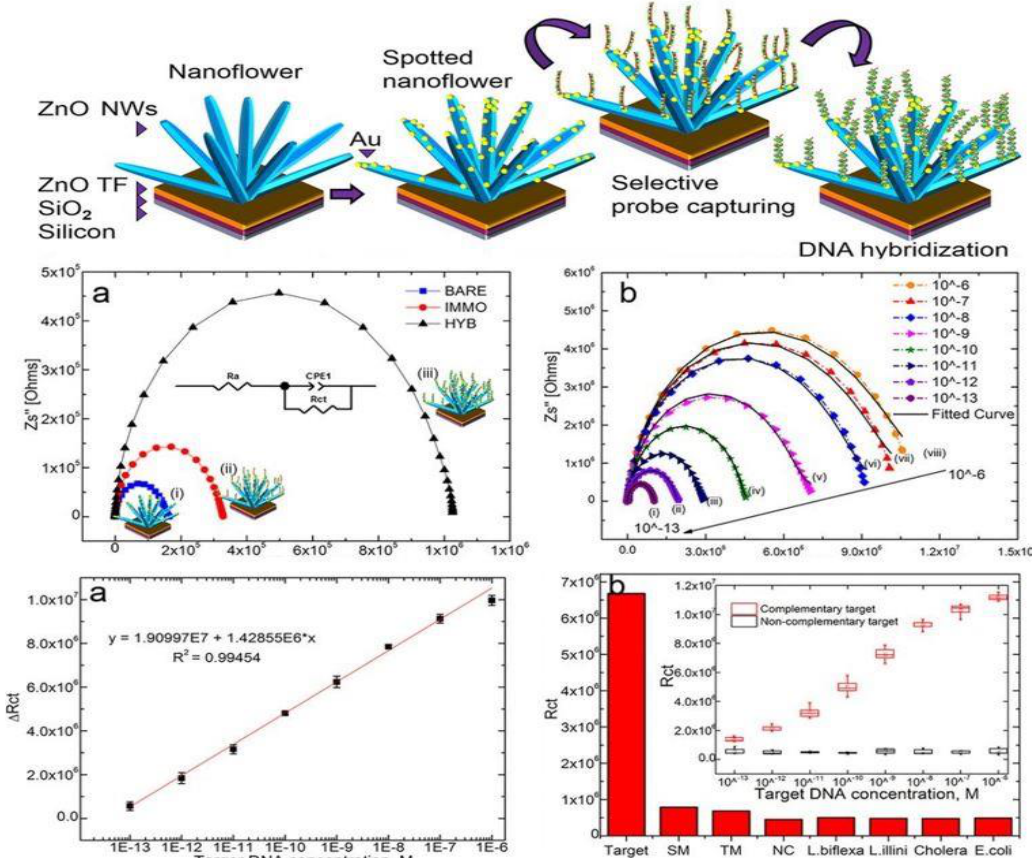
Figure 18. ( a ) Schematic illustration of the steps involved in the synthesis of the spotted nanoflower (NF) DNA Bioelectrode; ( b ) impedance spectra of ( i ) spotted NF, ( ii ) spotted NF/p-DNA (probe), and ( iii ) spotted NF/p-DNA/t-DNA (duplex) bioelectrode; ( c ) impedimetric response curve of spotted NF/p-DNA hybridized with different concentrations of complementary target DNA ( i – viii ) 10 μ M to 100 fM; ( d ) the linear regression curve for different concentrations of target DNA; ( e ) bar chart of the specificity of the spotted NF bioelectrode towards mismatching and cross hybrids — the inset shows a box plot of complementary and noncomplementary target oligonucleotides hybridized to the immobilized probe oligonucleotides at different target oligonucleotide concentrations. Reprinted with permission from Nature Publishing Group, Scientific Reports, Ref. [10]. This work is licensed under a